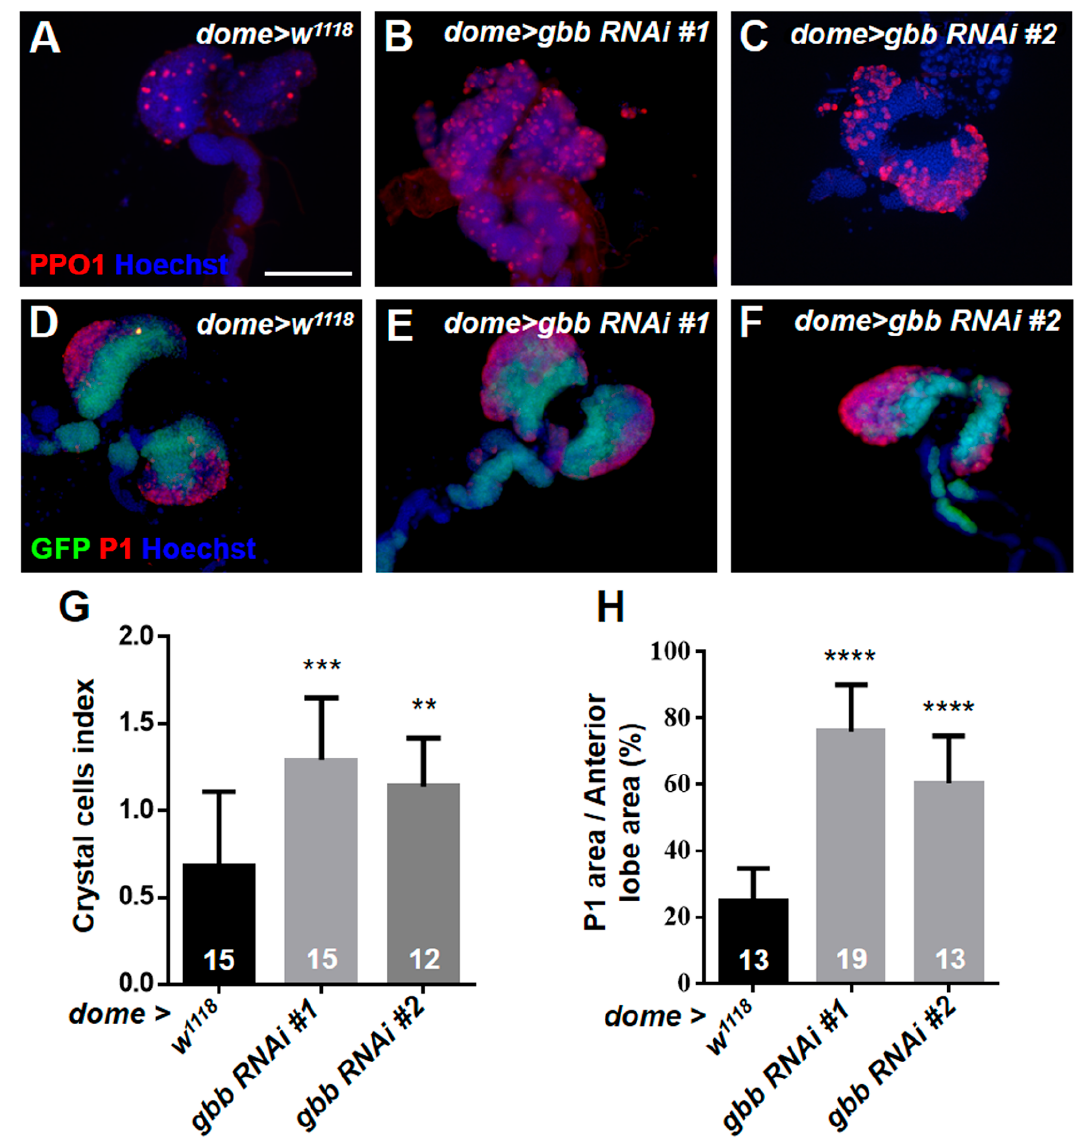
Figure 5. The knockdown of gbb in the MZ using the dome-Gal4 driver results in the massive differentiation of crystal cells and plasmatocytes. ( A – C ) Immunostaining of lymph gland with anti-PPO1 antibody. ( D – F ) Immunostaining of lymph gland with anti-P1 antibody. The GFP signal area represents the area of dome > GFP+ MZ. ( G , H ) Quantification of crystal cell number ( G ) and P1-positive area ( H ). For all quantifications: ** p < 0.01; *** p < 0.001; **** p < 0.0001 (Student’s t test). Scale bars: 100 μ m ( A – F ).